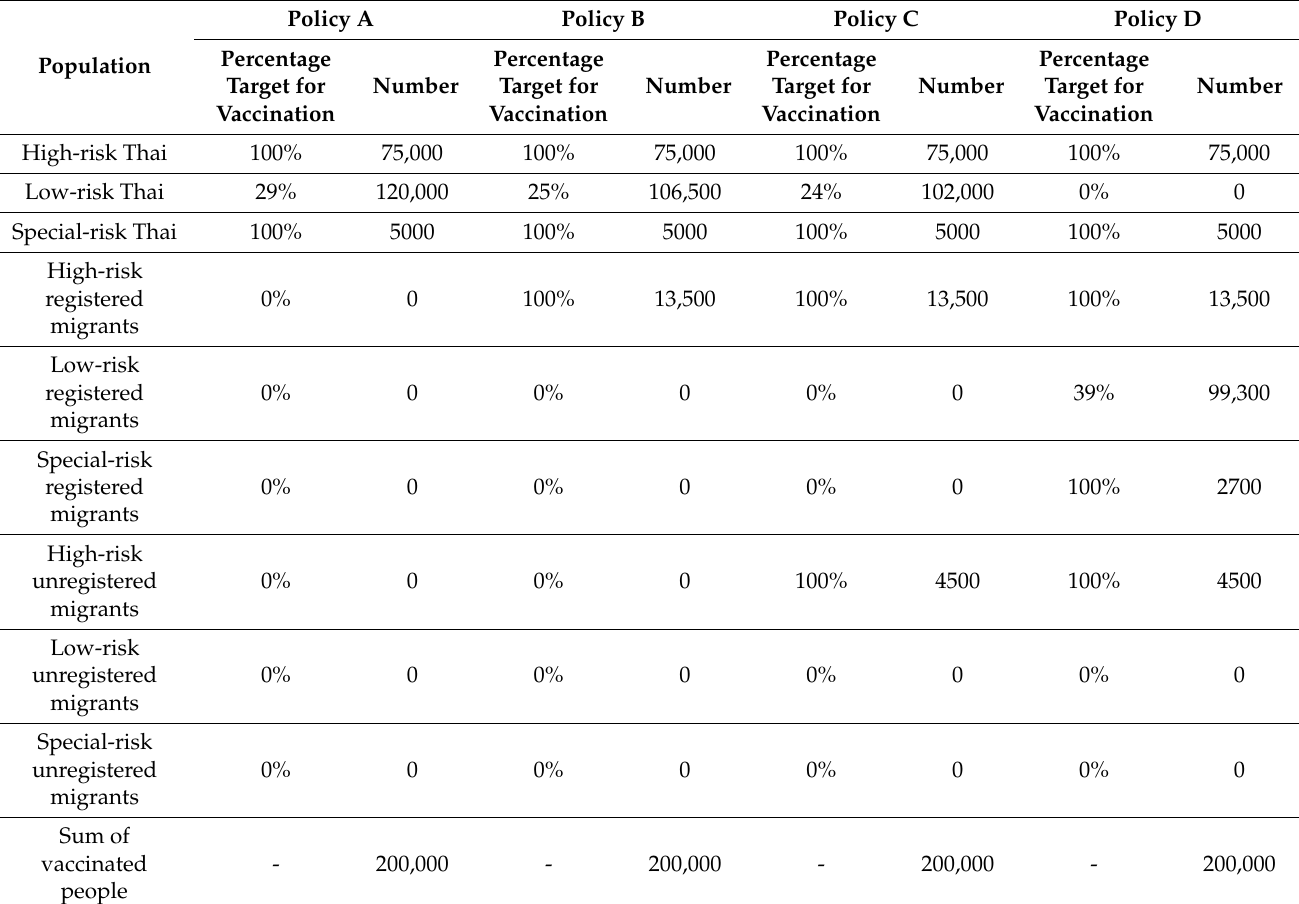
Table 3. Policy options based on a total of 200,000 vaccinated